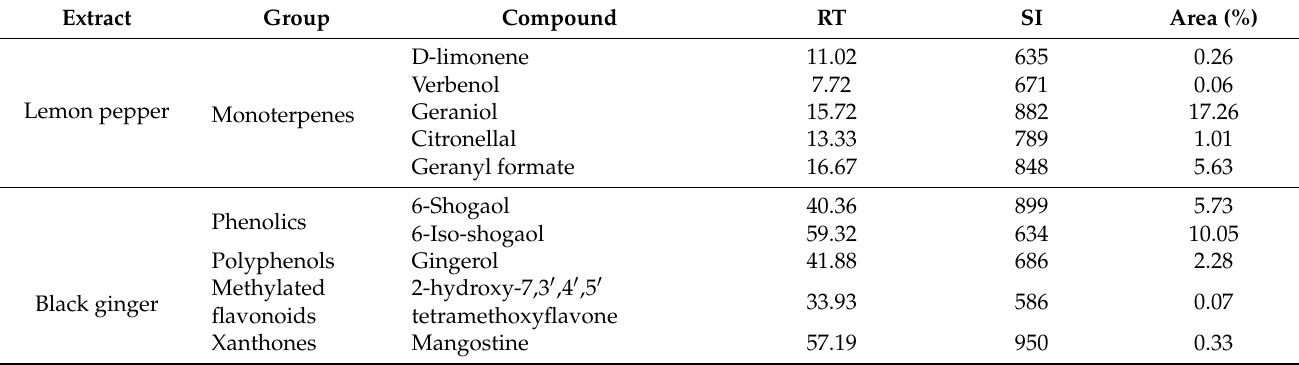
Table 1. Active compounds in lemon pepper and black ginger